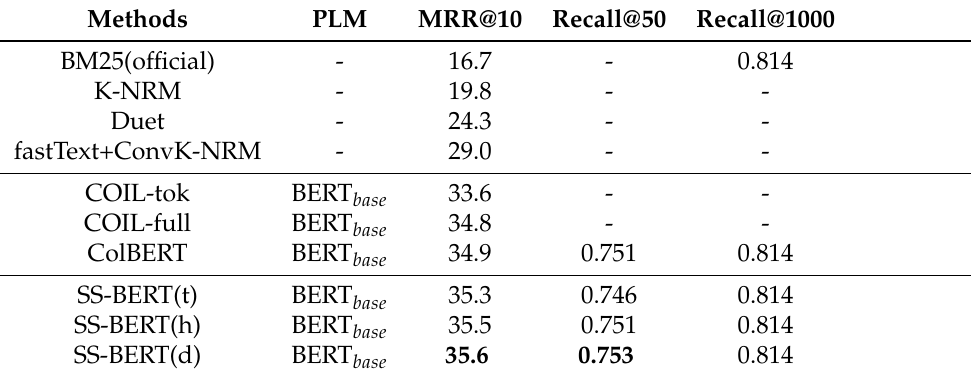
Table 6. The results in MS-MARCO passage rerank task, PLM means the pre-trained language models used in the dual-encoder. SS-BERT(t) means the model uses the negatives select method, SS-BERT(h) means the model uses the negatives select method and the data augmentation method, SS-BERT(d) means the model uses the negatives select method, the data augmentation method, and the passage evaluation